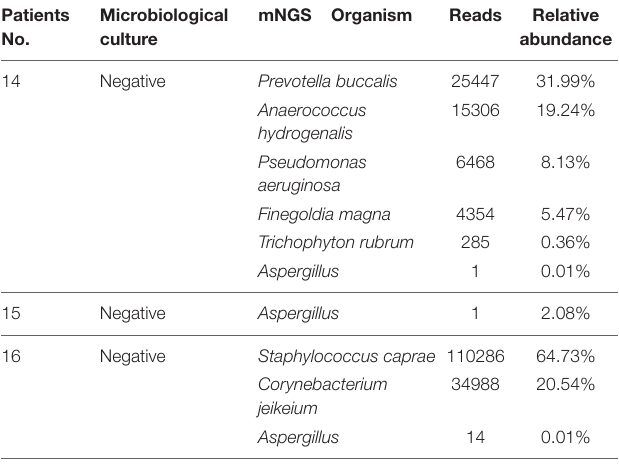
Among these 17 cases, 6 cases had detectable grown of both fungi and bacteria. Effat and Madany (2014) obtained keratinous debris from 18 patients (19 ears) with cholesteatoma and found culturable fungi in 17 of the samples (89%), but reported no data on culturable bacterial. More recently, Weiss et al. (2019) evaluated the microbiota associated with cholesteatoma by 16S rDNA gene sequencing in 19 patients. A total of 96 bacterial species and 34 fungal species were identified in association with the cholesteatoma matrix, but no difference was found between the relative abundance of fungal and bacterial taxa prevalent in the diseased tissue compared with that of the adjacent, uninvolved middle